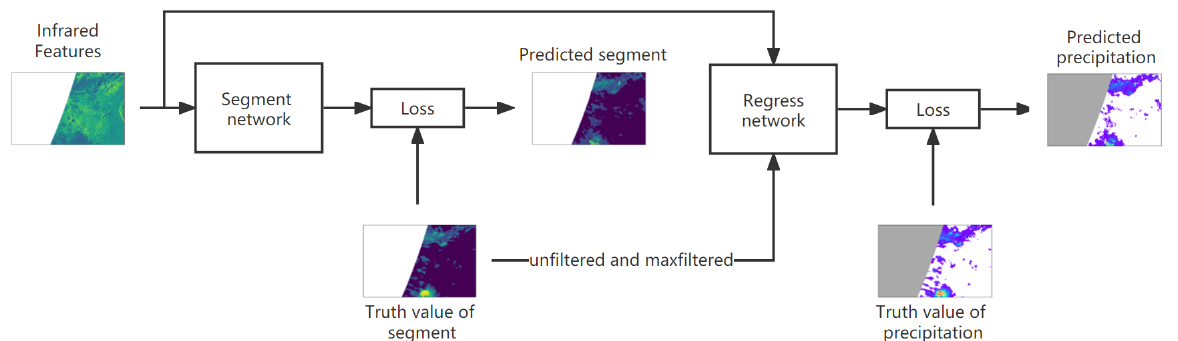
Figure 3. Flow chart of PrecipGradeNet training process.